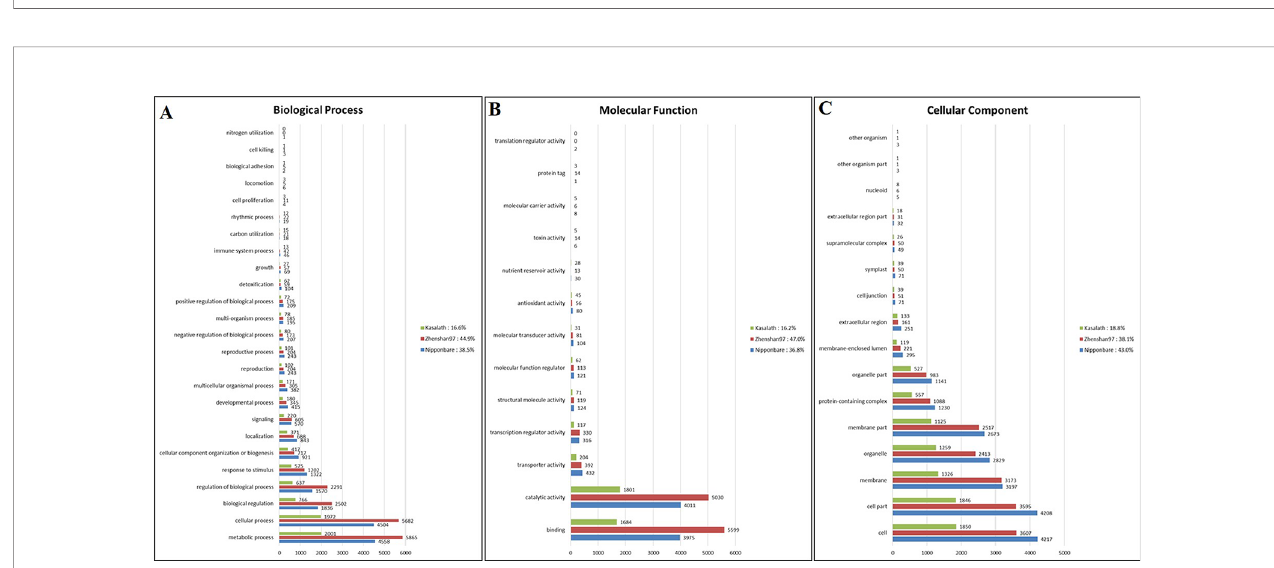
FIGURE 3 | Gene ontology (GO) analysis of Basmati genomes in comparison with Zhenshan 97, Kasalath, and Nipponbare genomes. (A – C) GO categories including biological process (A) , molecular function (B) , and cellular component (C) are shown.